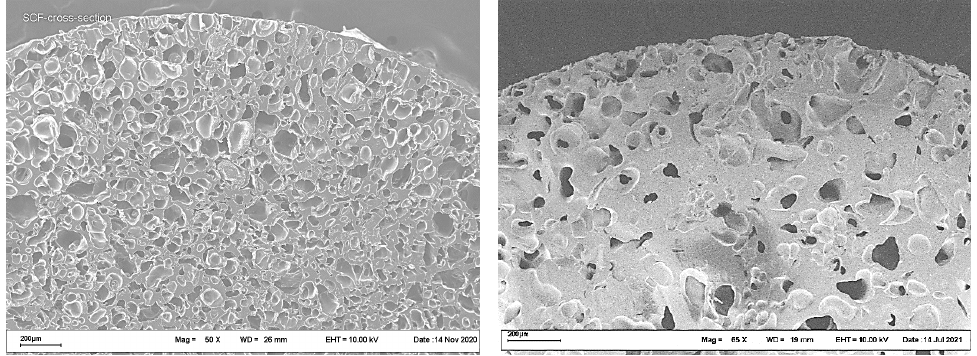
Figure 3. SEM images of PLGA/LFX scaffolds fabricated using scCO 2 ( left ) and scCHF 3 ( right ).